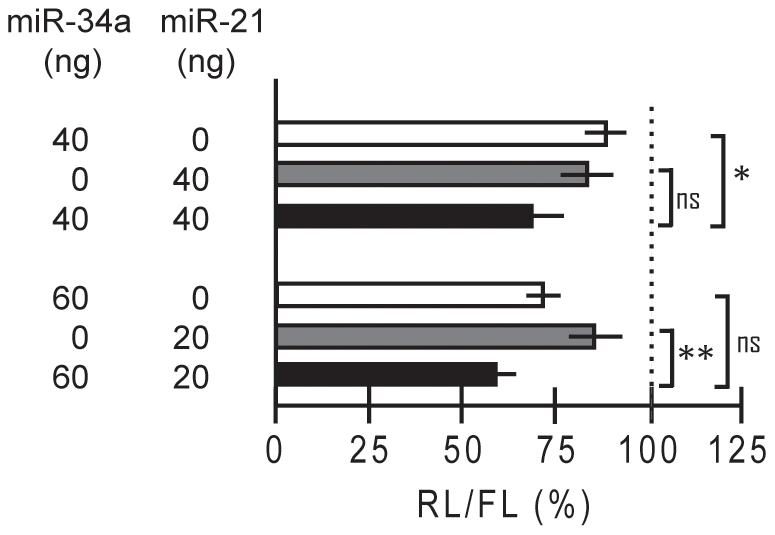

miR-34a and miR-21 cooperate on the HNF4A 3′UTR.The reporter plasmid with the full-length HNF4A 3′UTR (1–3180) was cotransfected into INS-1 cells with expression vectors encoding pri-miR-34a and/or a miR-21 as indicated. 24 h later Renilla luciferase activity was measured and standardized using the cotransfected firefly luciferase reporter. Each experiment involved three assays performed in triplicate and the activity in the presence of the empty expression vector was used for standardization (100%). By adding empty vector the amount of DNA was kept constant. The specificity of the miR-21 expression vector pCMV-miR21
[45] was verified by using the bona fide reporter Luc-TPM1-V1-UTR and its derivative Luc-TPM1-V4-UTR lacking a miR-21 binding site (Fig. S2). p-values of >0.05 (ns), <0.05 (*) and <0.01 (**) are calculated as indicated by brackets using an independent-samples t test.